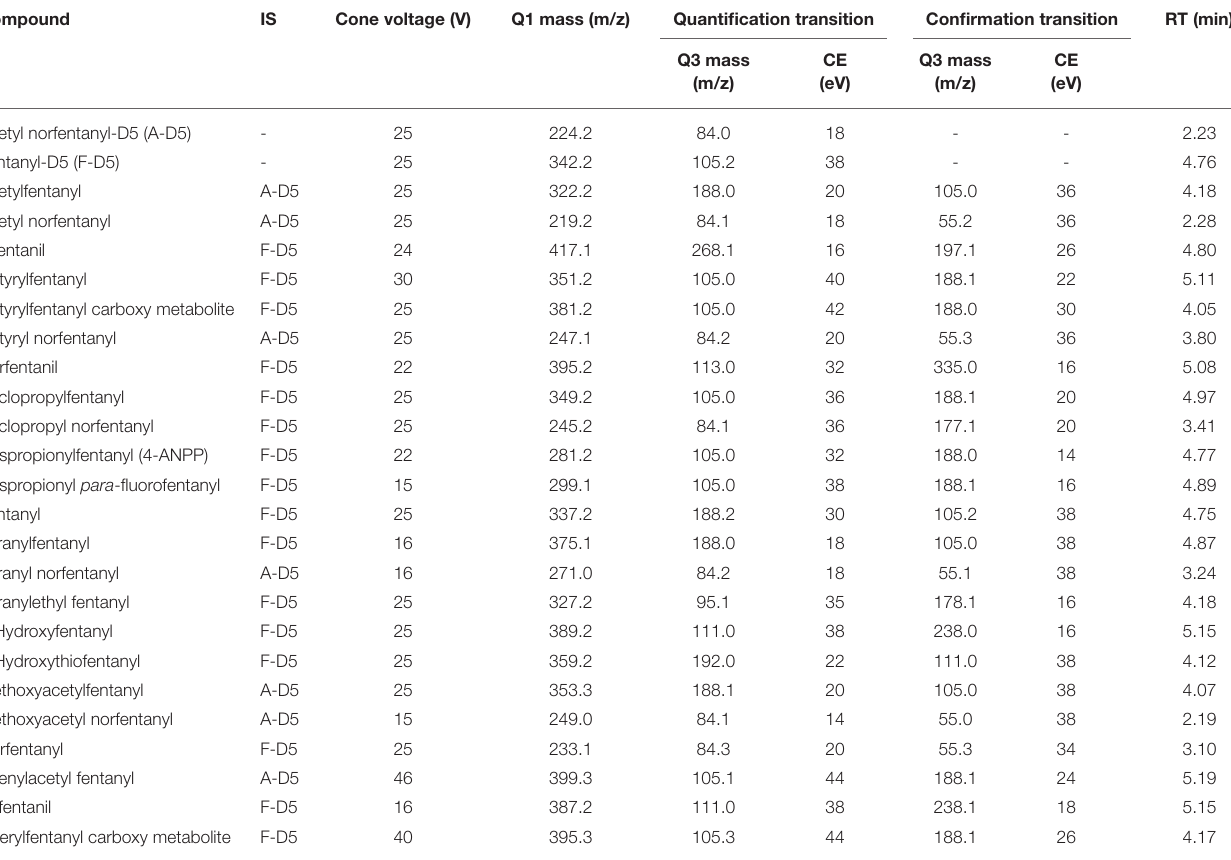
TABLE 1 | Mass spectrometry parameters for analytes and internal standards. Scan speed (dwell time) and detection windows were adjusted accordingly.